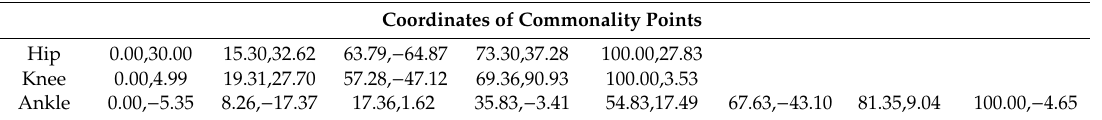
Table 2. Coordinates of commonality points of three